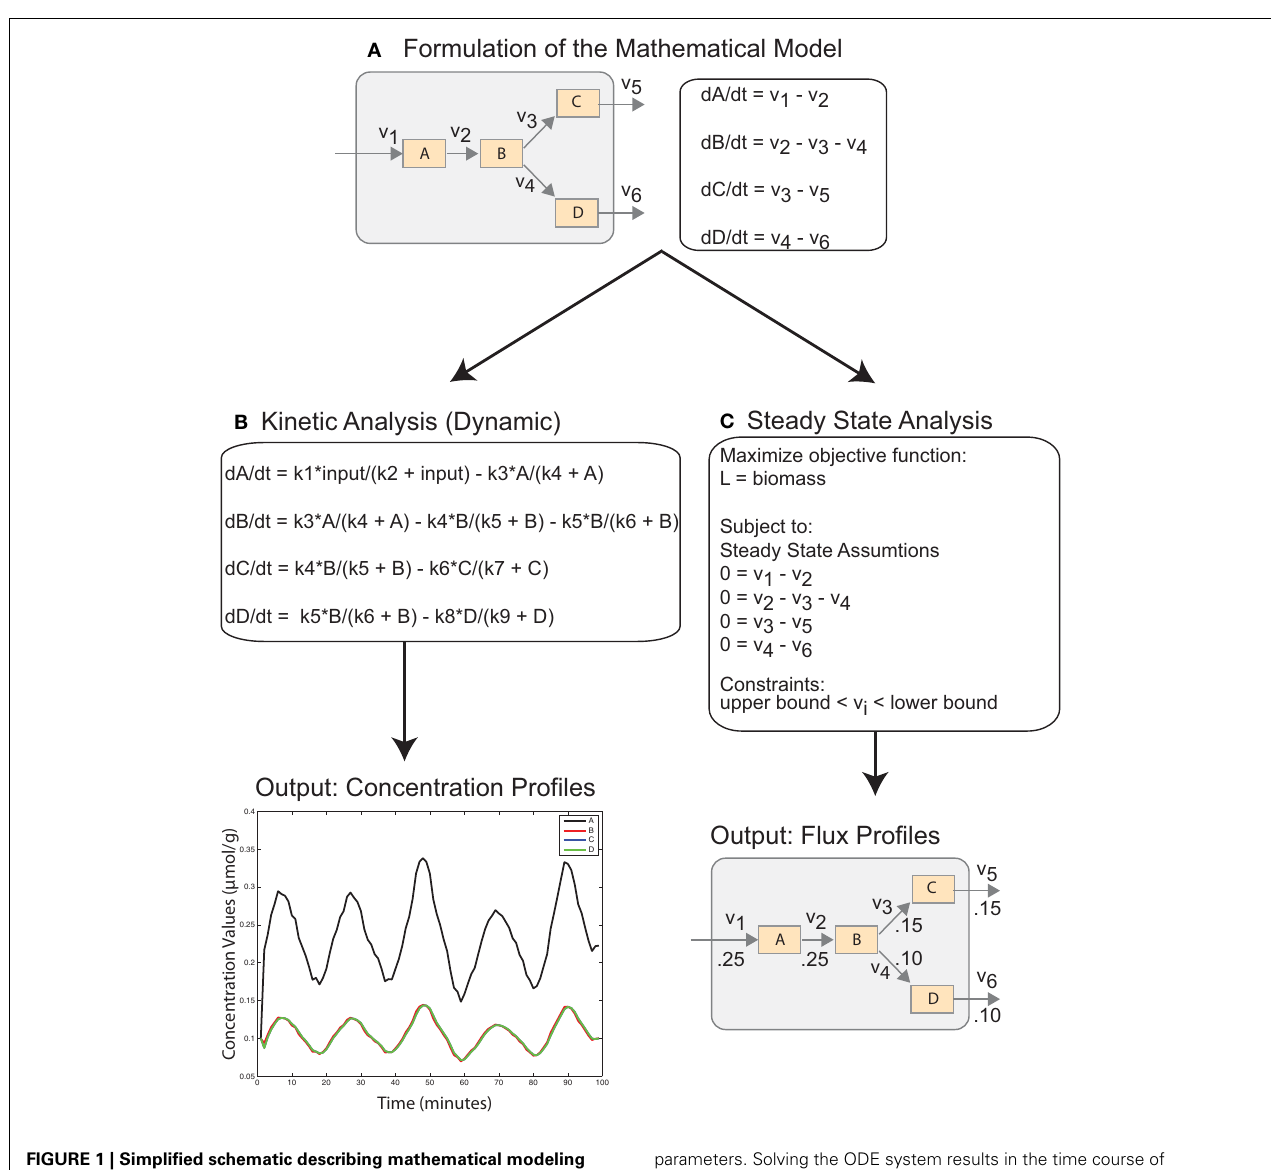
FIGURE 1 | Simplified schematic describing mathematical modeling of cellular systems with ODEs. (A) The cellular system is translated into a mathematical model with system of ODEs reflecting the mass balance of the system. (B) Dynamic analysis of the system requires specification of fluxes as non-linear functions, which depend on a number of unknown